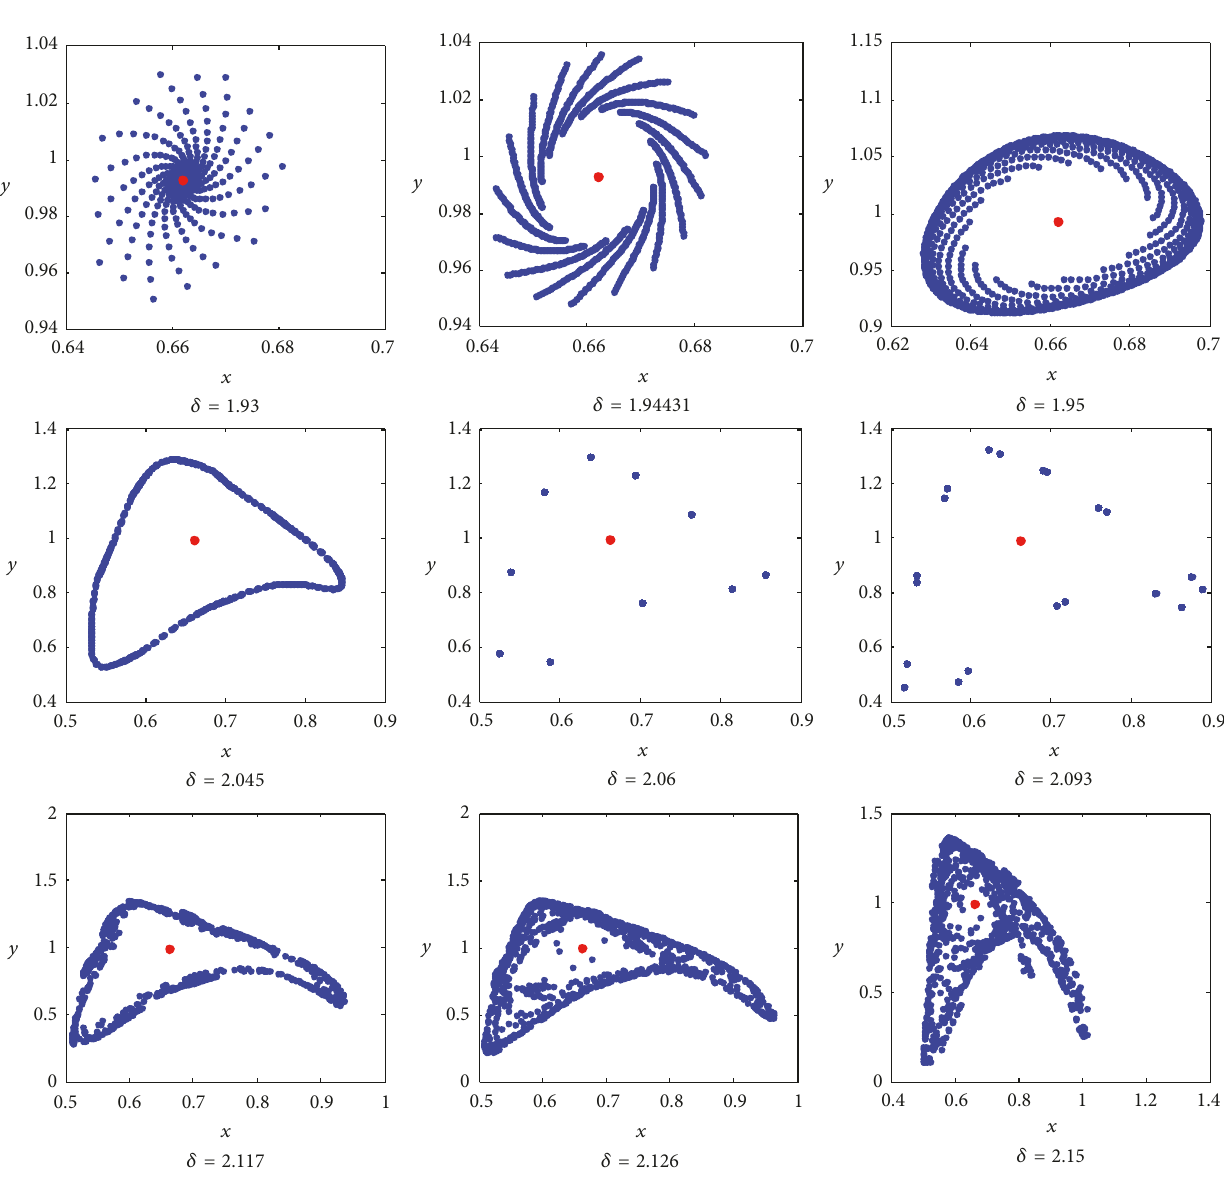
Figure 3: Phase portraits of bifurcation diagrams Figures 2(a) and 2(b) for different values of 𝛿